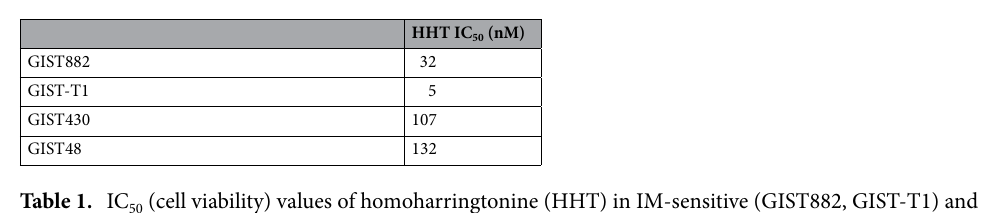
Table 1. IC 50 (cell viability) values of homoharringtonine (HHT) in IM-sensitive (GIST882, GIST-T1) and IM-resistant (GIST430, GIST48) GIST